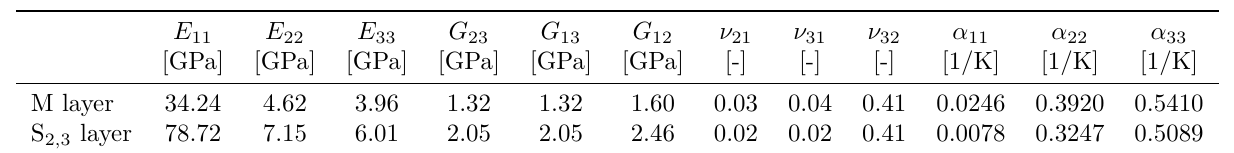
Table 3. Effective properties at cell wall level from analytical homogenization.